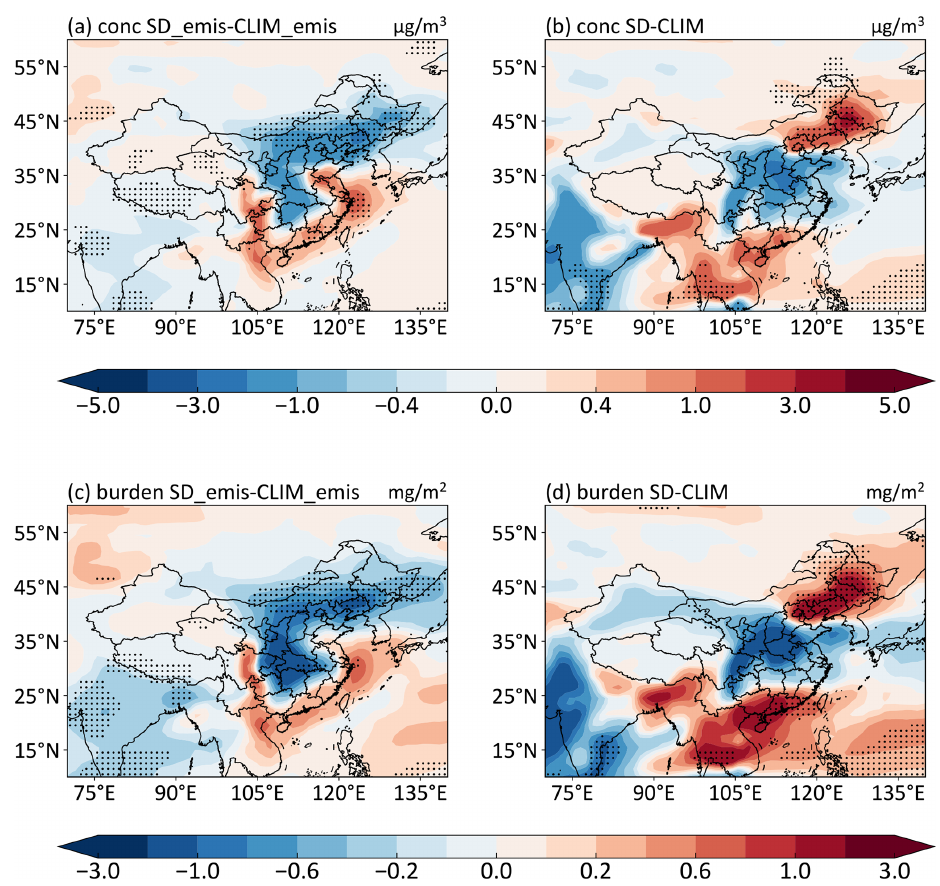
Figure 9. Composite differences in DJF mean near-surface PM 2 . 5 concentration (µgm − 3 ) and aerosol column burden (mgm − 2 ) between SD_emis and CLIM_emis (a, c) SD and CLIM (b, d) . The stippled areas indicate statistical significance with 90% confidence from a two-tailed t